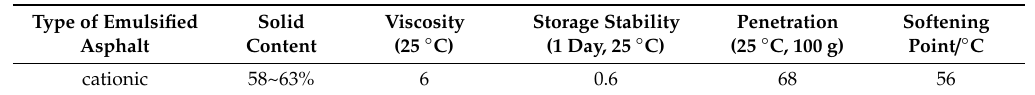
Table 2. Properties of emulsified asphalt.